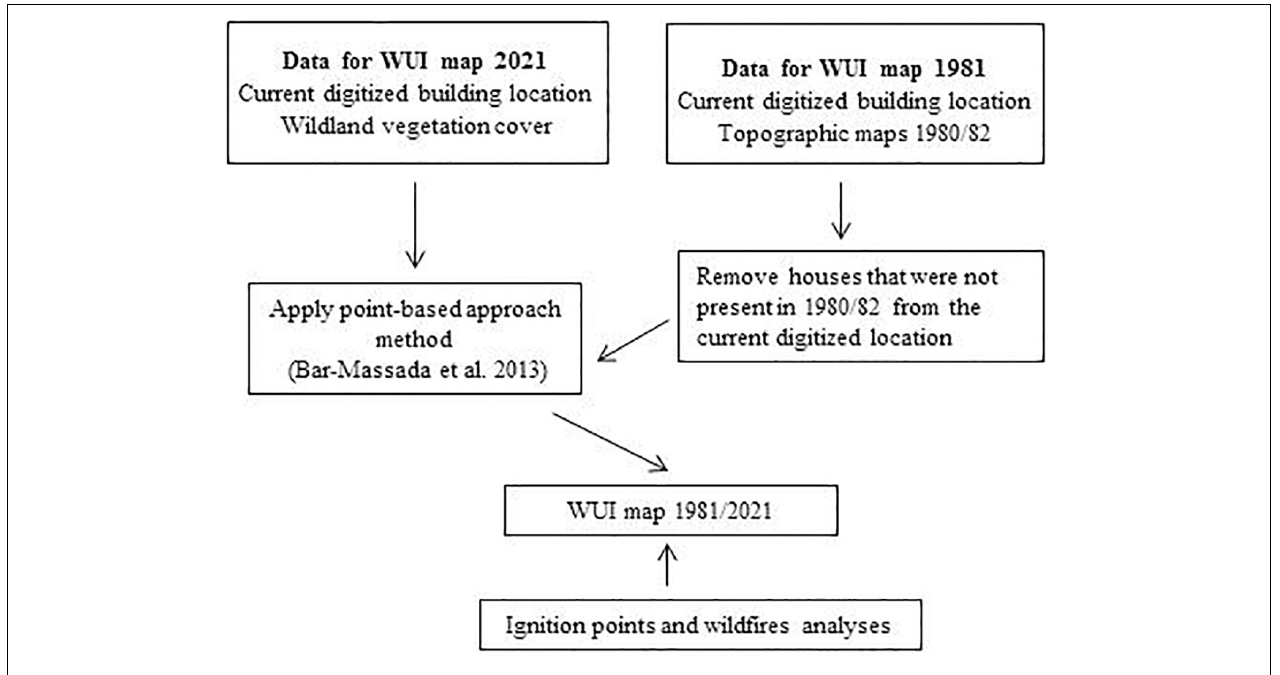
FIGURE 3 | A chart showing the workflow of the study. TABLE 1 | Area and number of houses in the study area for the periods 1980–1981 and 2021 and its